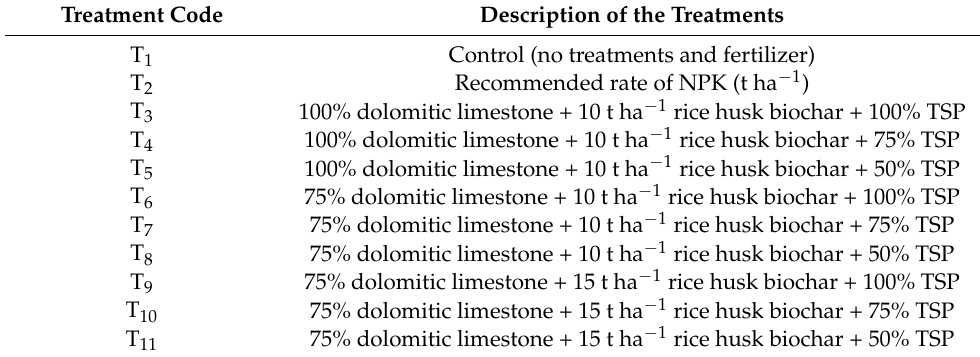
Table 3. Teatments applied in the pot